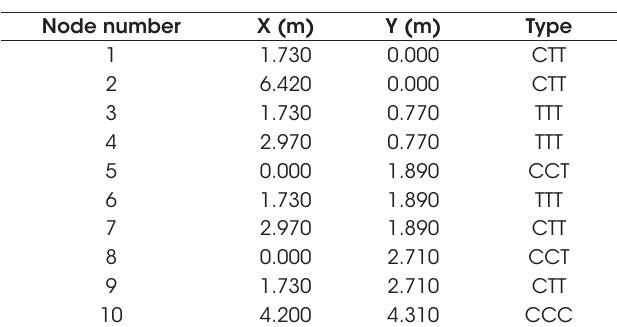
Identification of nodes of the Example